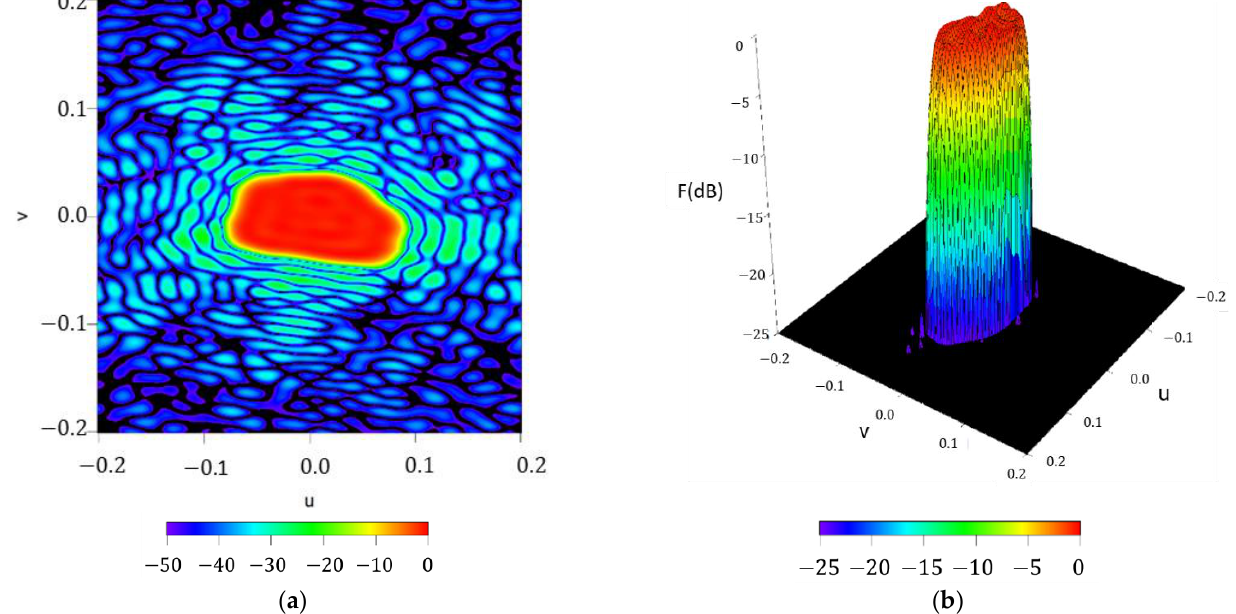
Figure 16. Reconstructed pattern of the required footprint for the case of illuminating continental Europe by means of the discretized array antenna in presence of 5 × 5 subarrays: ( a ) interpolated image with a threshold level set at − 50 dB; and ( b ) surface plot with a threshold level set at − 25 dB. The pattern is zoomed in on the region defined by u = [ − 0.2,0.2 ] and v = [ − 0.2,0.2 ] .